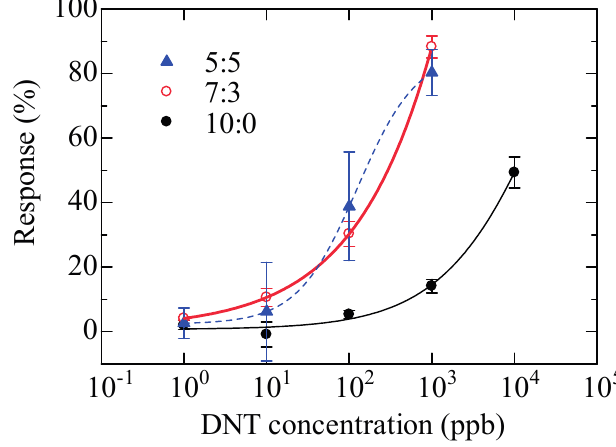
Figure 12. Response curves obtained by displacement assay of three ratios of DNP–gly-modified surfaces